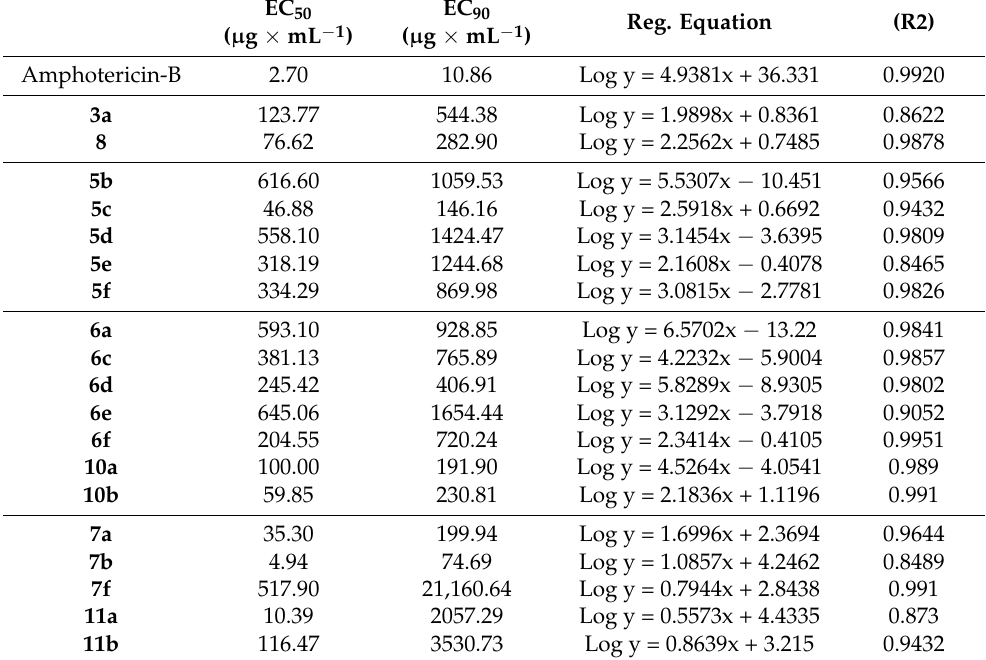
Table 2. Antifungal activity of the selected compounds against Rhizoctonia solani on PDA, EC 50 , and EC 90 after probit